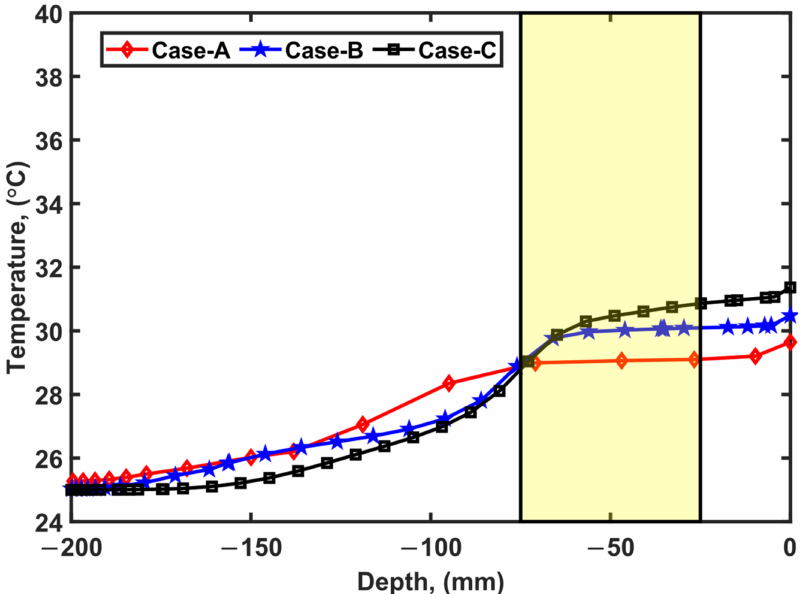
Figure 4. At 1600 s, a mesh sensitivity investigation shows thermocline variation at a position opposed to the steam condensation zone. Cases A, B, and C represent various meshes employed in the present work with decreasing coarseness. The shaded region shows the depth over which steam condensation takes place and heat is generated to drive the buoyancy current.